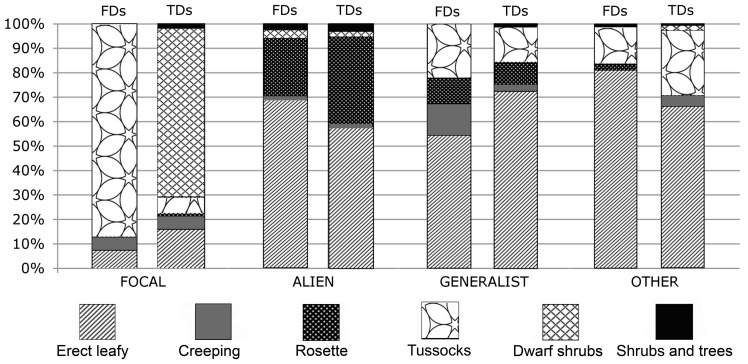
Distribution of growth forms within the selected species groups in the two zones. FD, fore dune zone; TD, transition dune zone.